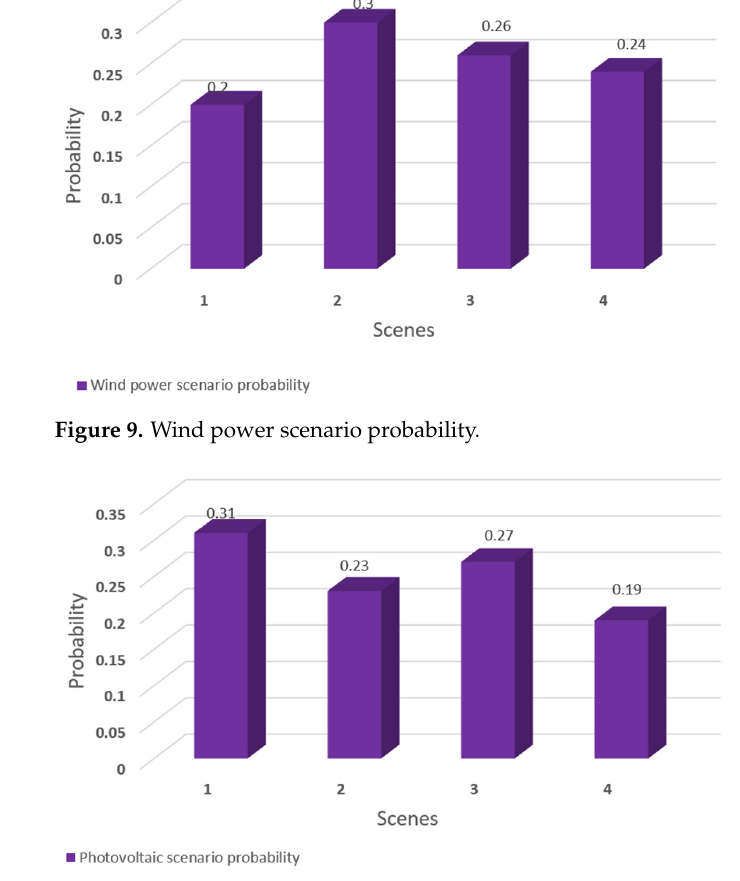
Figure 10. Photovoltaic scenario probability.